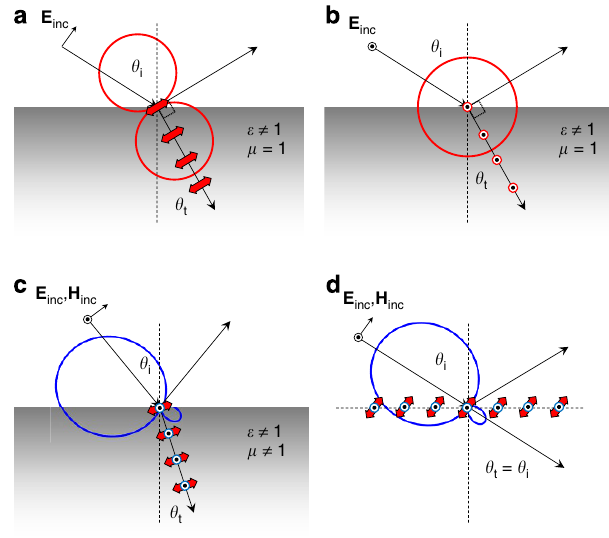
Figure 1 | Microscopic interpretation of Brewster effect and proposed metasurface. ( a ) p -polarized light impinging on a dielectric medium, e a 1 and m ¼ 1, under usual Brewster’s condition. Red line shows 2D emission diagram of electric dipoles excited inside the material by the refracted wave. ( b ) Same as in a but for s -polarized incidence, for which no Brewster effect can be observed. ( c ) Generalized Brewster effect for a dielectric medium with electric and magnetic response, e a 1 and m a 1. Blue line shows 2D emission diagram of interfering electric and magnetic dipoles excited inside the material by the refracted wave. ( d ) Generalized Brewster effect in the proposed array of high refractive index nanoparticles. NATURE COMMUNICATIONS|7:10362|DOI: